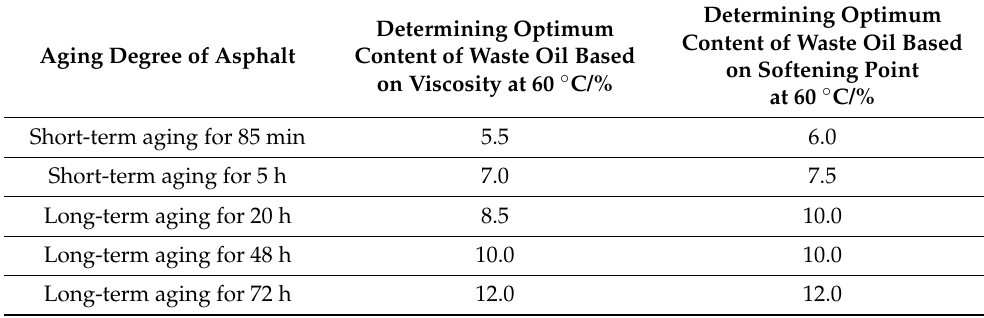
Table 15. Optimum content of waste oil based on determining different physical properties